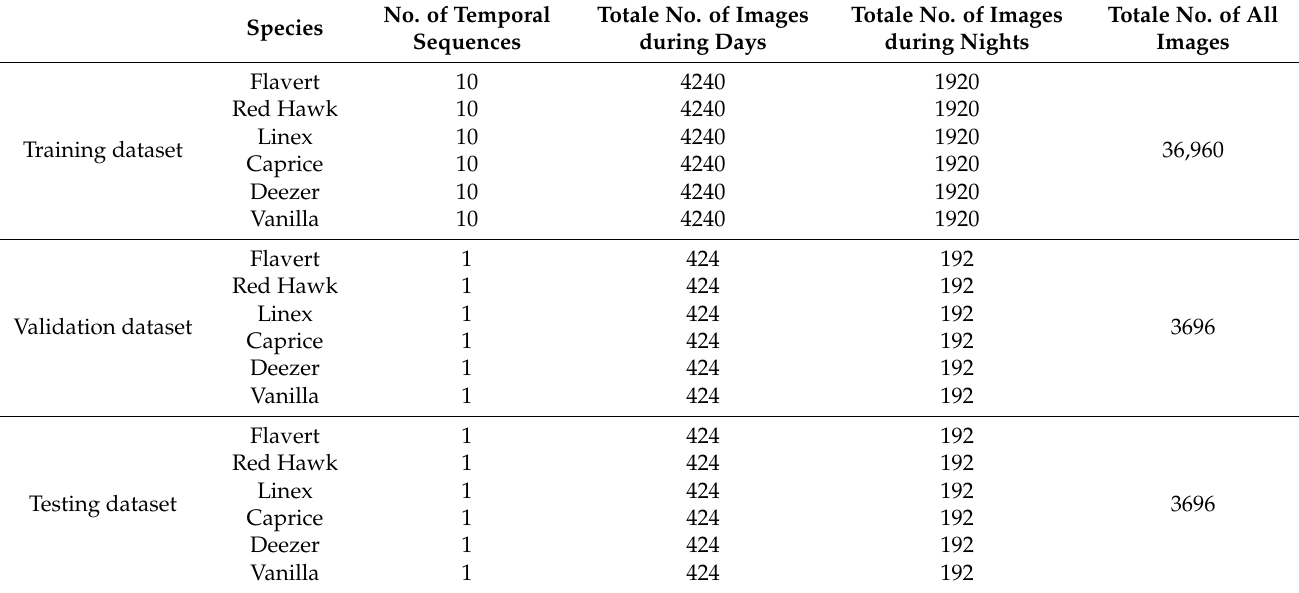
Table 1. Description of the RGB-Depth dataset used in this study.